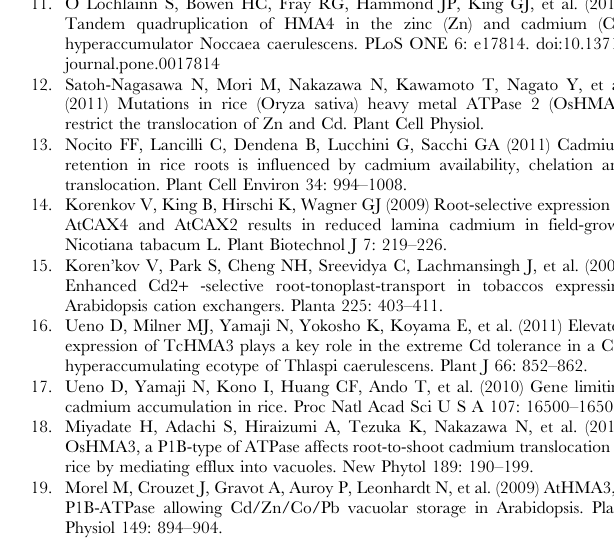
Figure S1 Geographic distribution of accessions and their alleles at the SNP Chr4:14736658 . Map showing the geographical